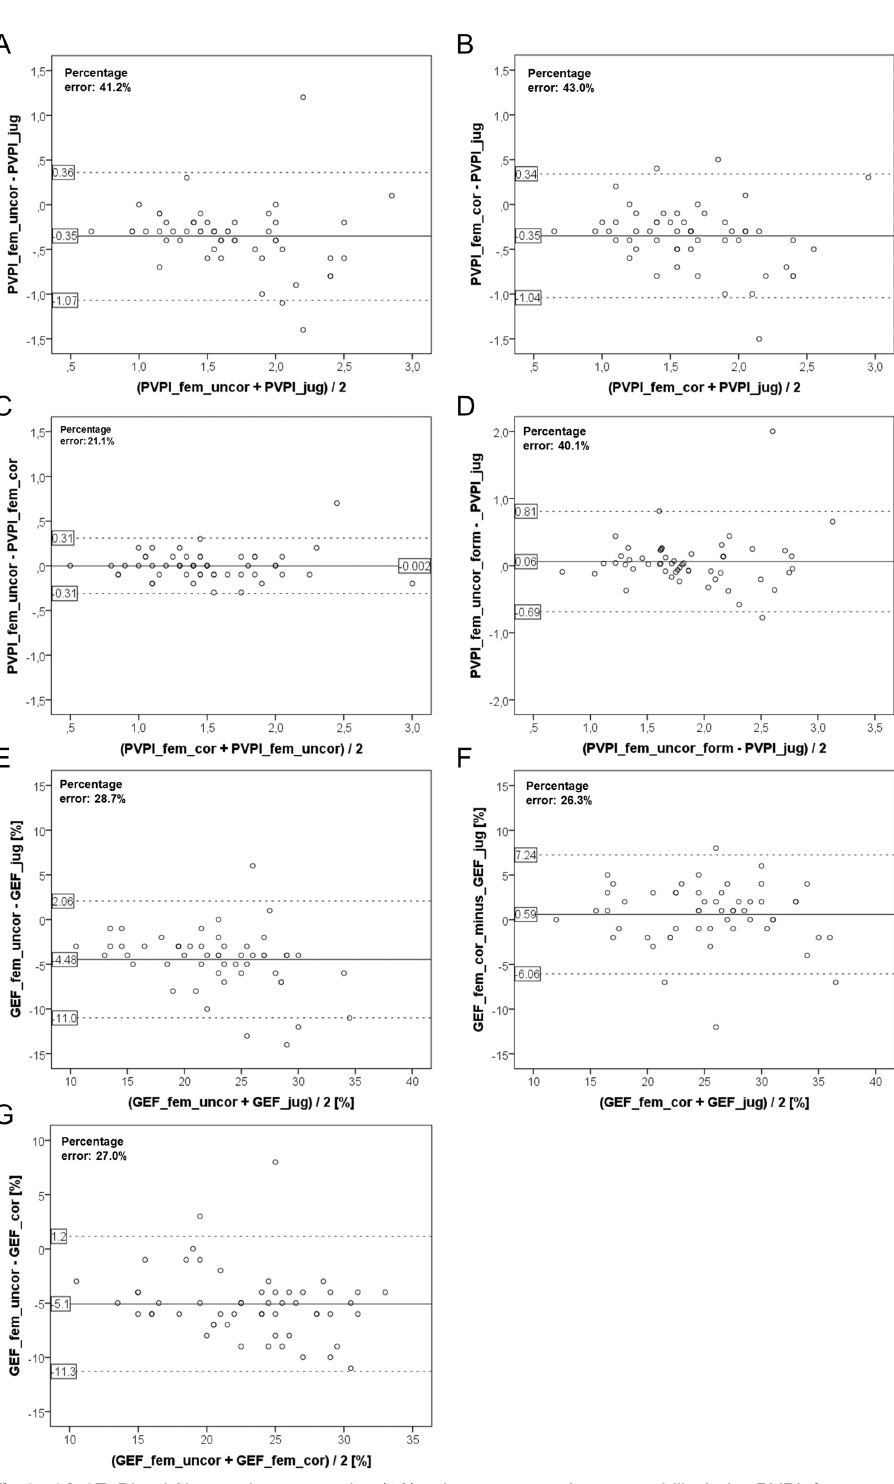
Fig 1. 1A-1F: Bland Altman plots comparing(1A) pulmonary vascular permeabilityindex PVPI_fem_uncor derived from femoral injectionwithout activatingof a potentialcorrection by the device to the gold standard measurement PVPI_jug using a jugularCVC for indicatorinjection, (1B) pulmonary vascular permeability index PVPI_fem_cor derived from femoral injectionafter activiationof a potential correction by the device to the gold standardmeasurement PVPI_jug using a jugularCVC for indicatorinjection, (1C) pulmonary